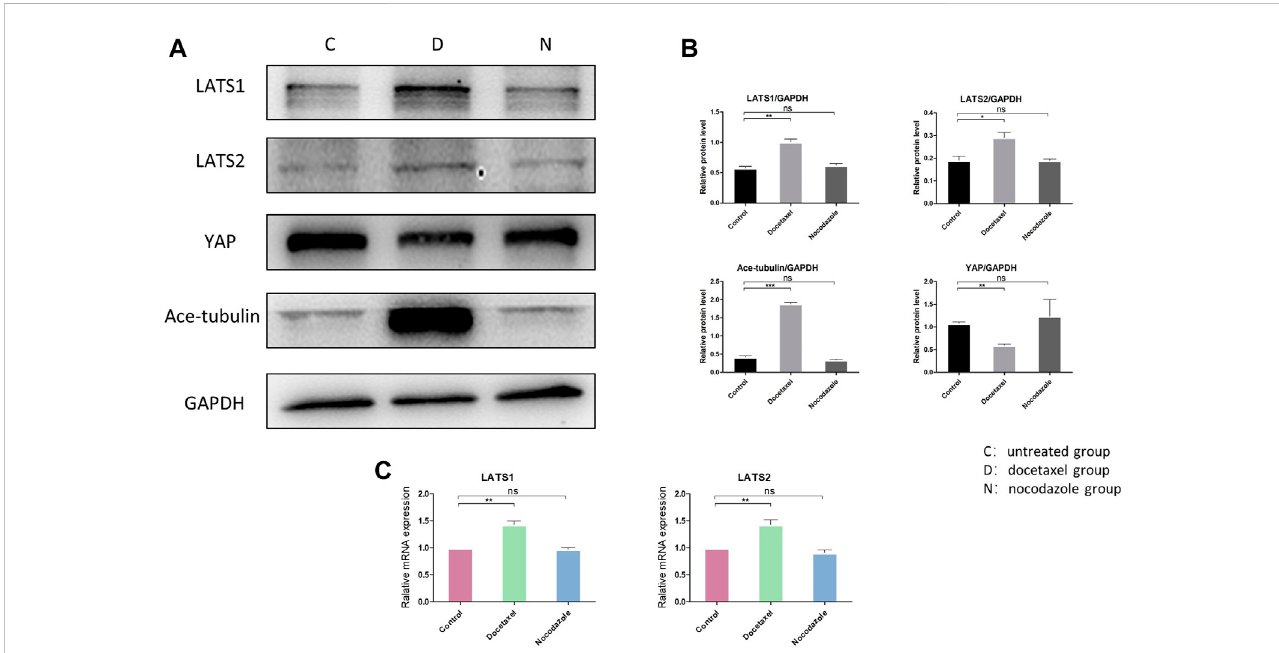
FIGURE 4 TheeffectofMTstabilizationonHippopathway ofNPcells. (A) WesternblotanalysisofLATS1,LATS2andAce-tubulinexpressioninNPcellstreatedwith docetaxel and nocodazole for 1 week. (B) Quanti fi cation ofthe data of (A) . n = 4. (C) Q-PCR ofLATS1 and LATS2 expression inNP cells treated with docetaxel and nocodazole for 1 week. Data are represented as the mean ± SEM. * p < 0.05, ** p < 0.01, *** p <